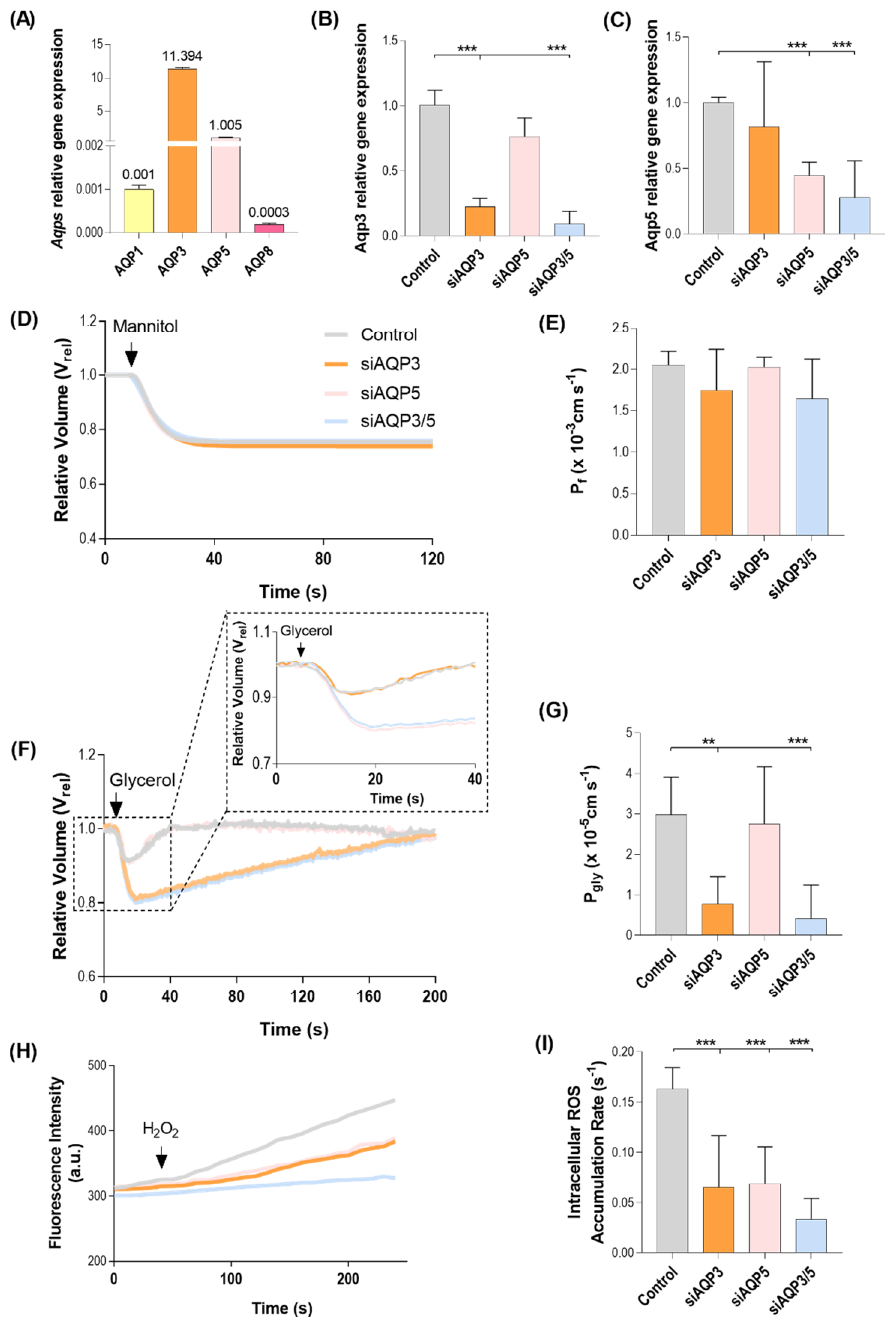
Figure 1. AQP3 and AQP5 are the most abundant AQPs in pancreatic BxPC-3 cells. ( A ) mRNA expression levels of the AQP paralogs naturally expressed in BxPC-3 cells. Values normalized to HPRT-1. ( B – G ) Validation of the loss-of-function model. ( B , C ) mRNA expression levels of BxPC-3 cells silenced for AQP3 ( B ) and AQP5 ( C ). Values normalized to HPRT-1. ( D , F ) Time course of cell volume changes caused by osmotic and solute challenges with mannitol ( D ) and glycerol ( F ) in control, siAQP3, siAQP5, and siAQP3/5 cells. ( E , G ) Water (P f ) ( E ) and glycerol (P gly ) permeabilities ( G ). ( H ) Representative traces of intracellular ROS accumulation, given by H 2 -DCFDA fluorescence increase after addition of 100 μM H 2 O 2 . ( I ) First-order kinetic rate constant of H 2 O 2 influx through endogenous AQP3 and AQP5 in BxPC-3 cells after a 100 μM H 2 O 2 challenge. Data represent a mean of n = 3 independent experiments ± standard error of the mean (SEM); n = 10 for permeability assays. ** p < 0.01; *** p < 0.001; both silenced vs. control cells; siAQP3, AQP3-silenced cells; siAQP5, AQP5-silenced cells; and, siAQP3/5, AQP3-, and AQP5-silenced cells.